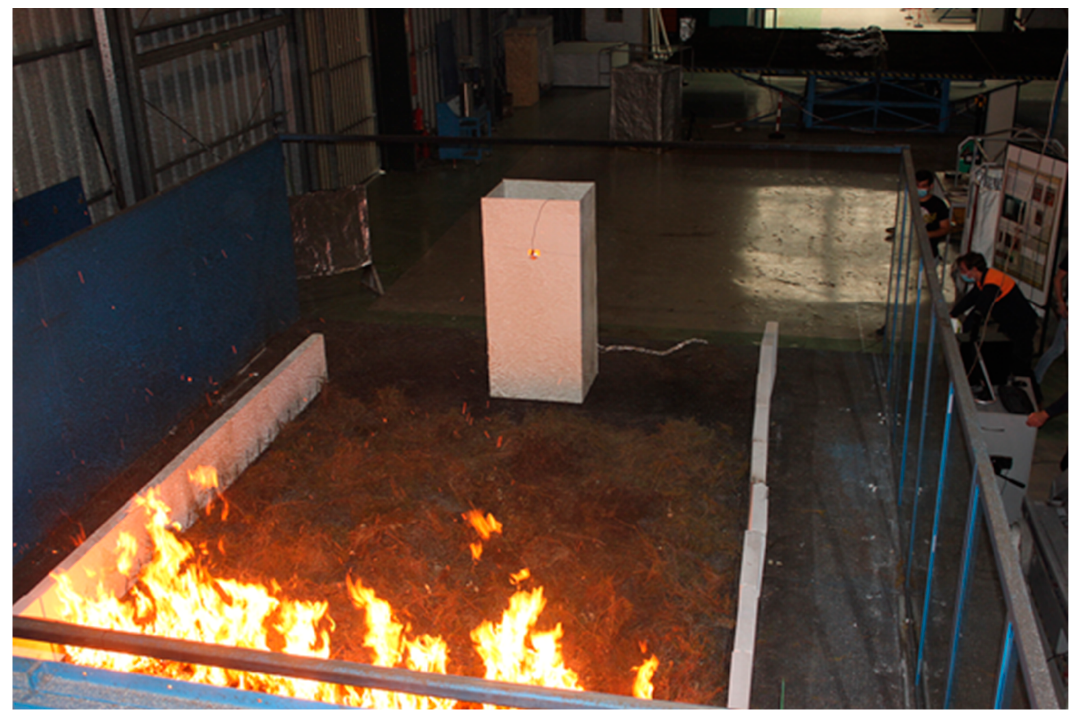
Figure 3. General view of the tests. Table 2. Conditions of the experimental tests